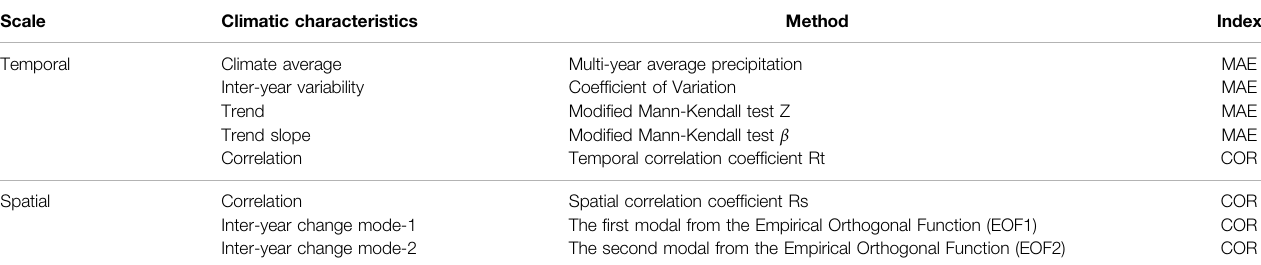
TABLE 2 | Statistical indices and evaluation methods applied in this